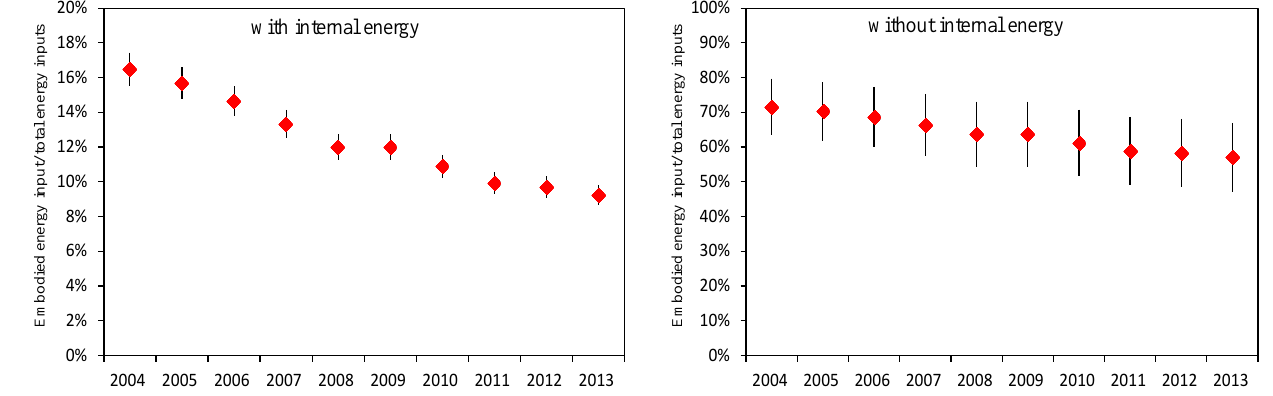
Figure 6. The ratios of embodied energy input to total energy